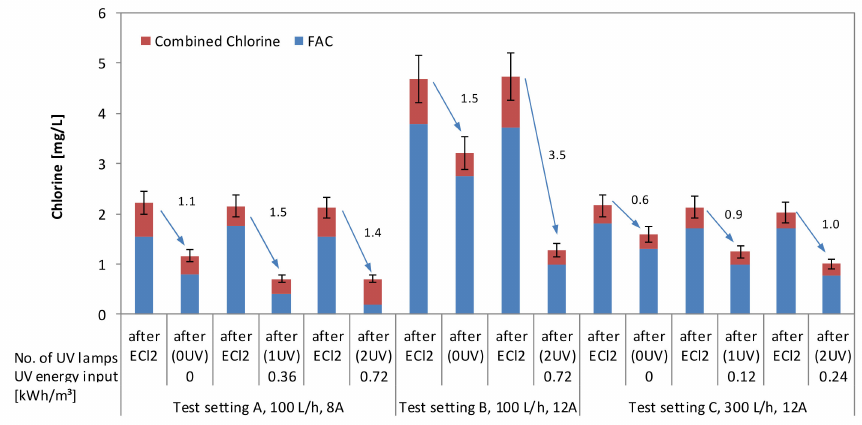
Figure 9. FAC and total chlorine concentrations measured in three di ff erent settings during field tests with Elbe river